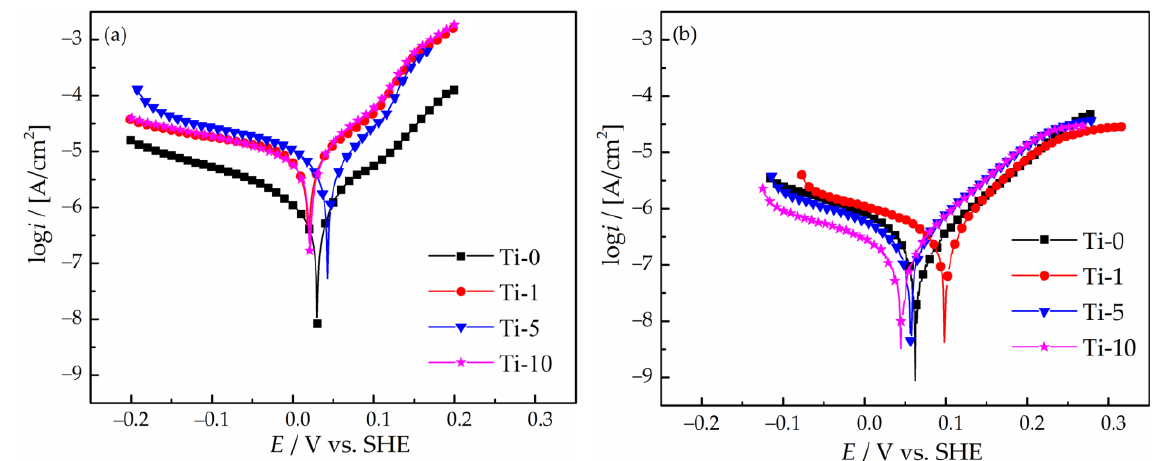
Figure 10a. The electrochemical parameters of the corrosion process calculated from the potentiodynamic polarization data are summarized in Table 3.